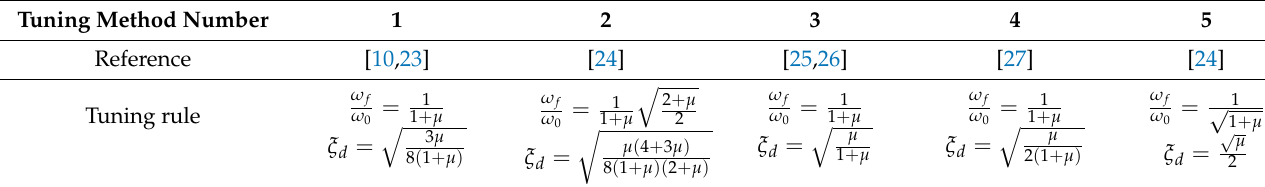
Table 1. Tuning methods for